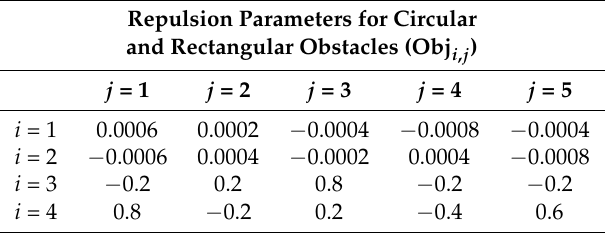
Table 2. Automatic Assignment of Repulsion Parameters.